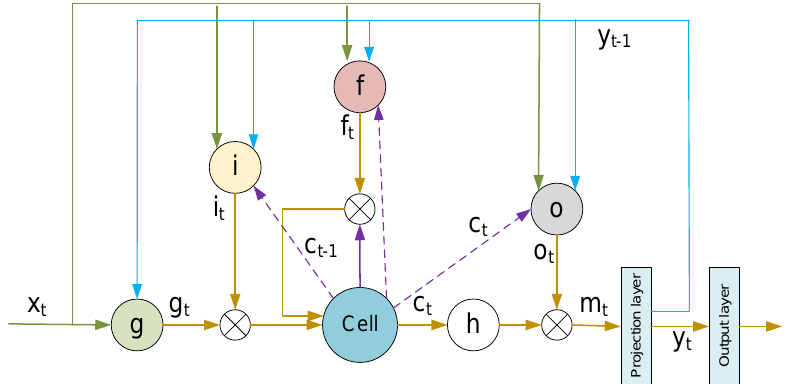
Figure 1. LSTM network